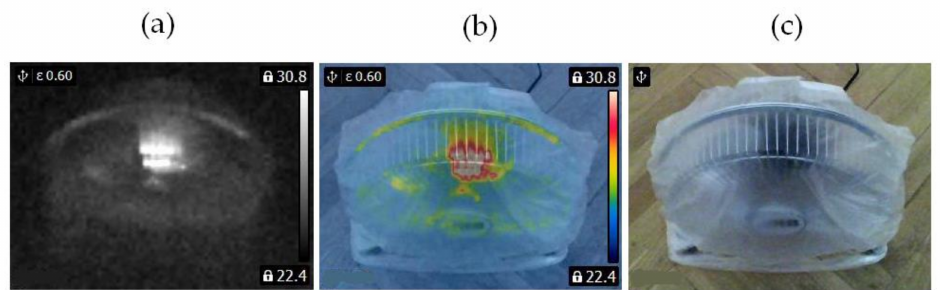
Figure 2. Healthy BLDC motor at 2100 rpm ( a ) gray-scale, ( b ) rainbow scale ( c ) photo.